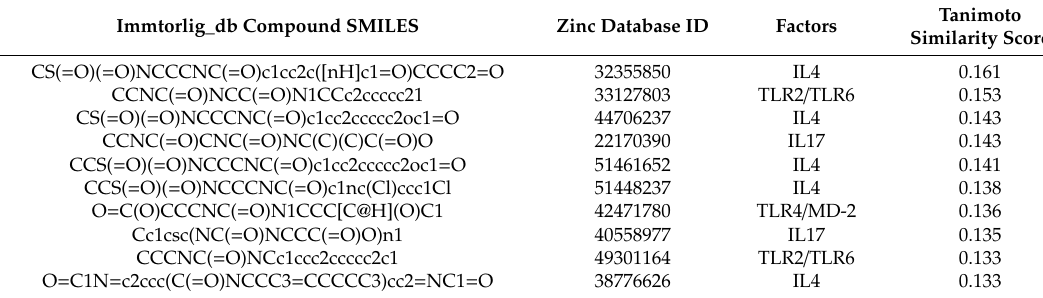
Table 2. Toll-like receptors and other immune factors binding to the ligand